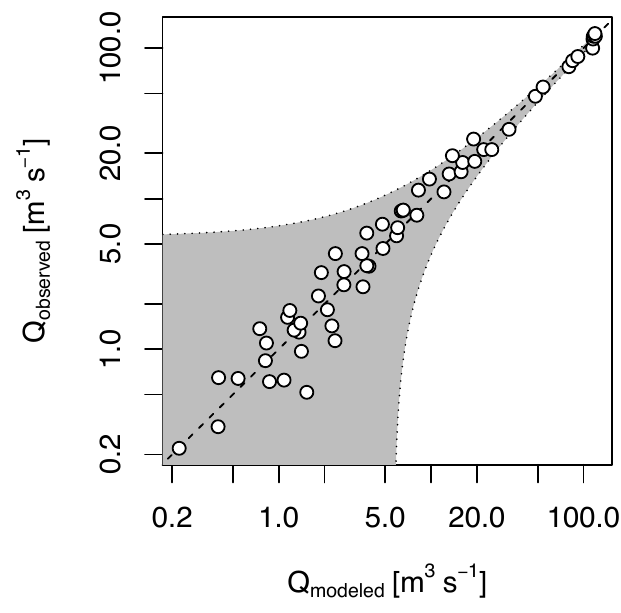
Figure 4. Comparison of observed and modeled mean annual discharges at different gauging sites in the stream network. (Regression: Q Shaded area is the 95% confidence band. Note that both scales are